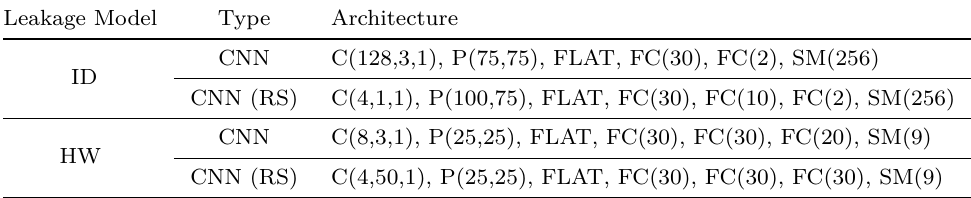
Table 12: The best found architectures for the ASCAD random keys dataset.